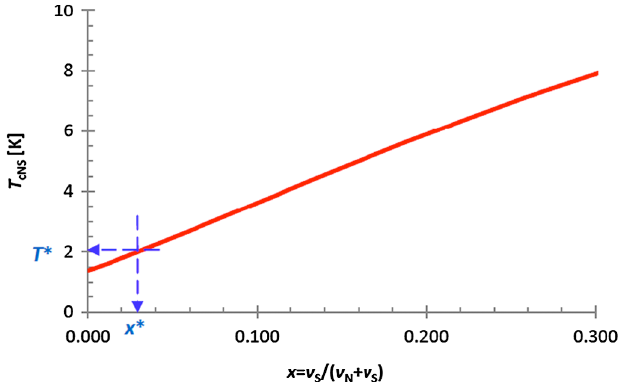
FIG. 2. Critical temperature of the NbO = Nb composite in the Cooper limit of the proximity effect vs the volume fraction = ð v þ v Þ of the S component (Nb). x ¼ v S N S